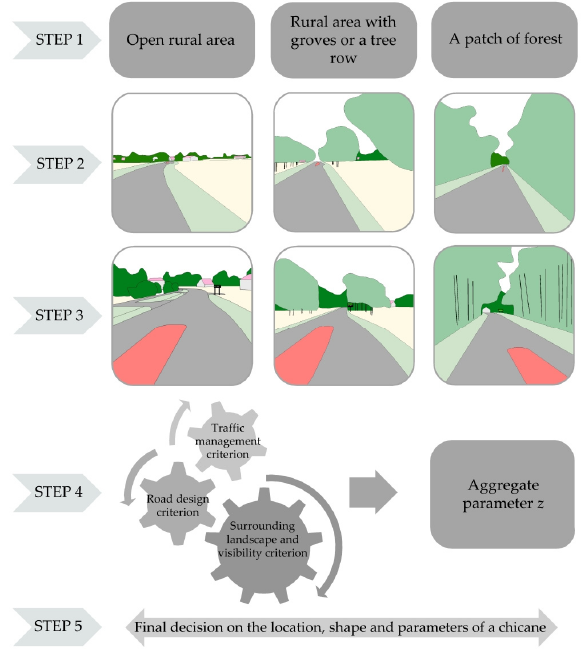
Figure 21. Proposed design process–i.e., selection of the chicane location within the transition zone to the village, with 70 km/h posted speed limit.